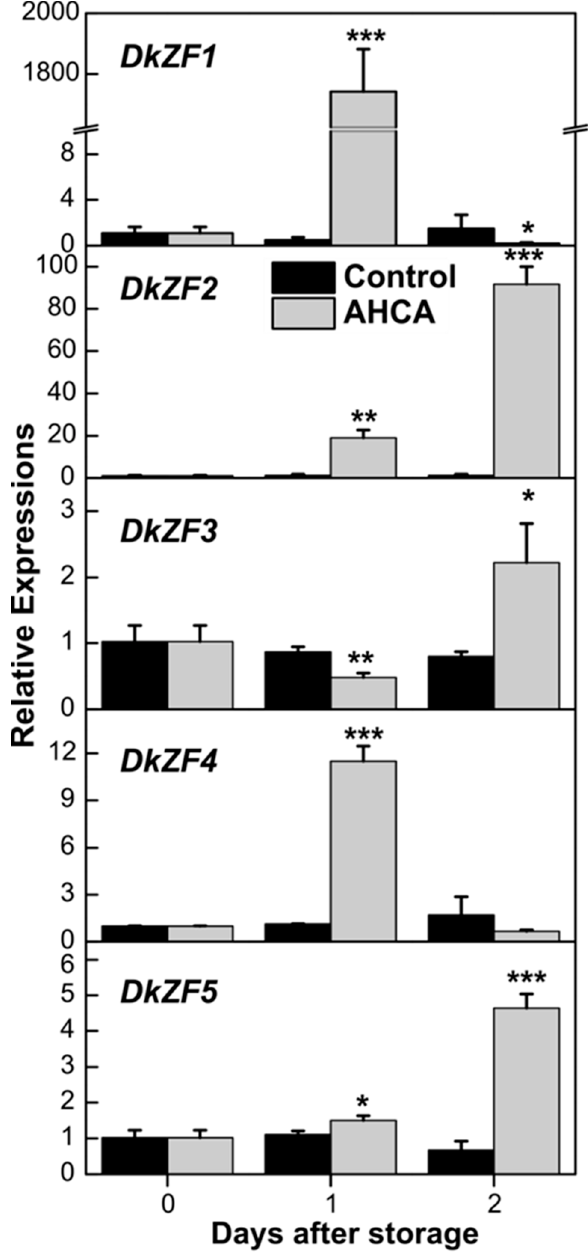
Figure 2. Expression analysis of DkZF genes in response to high-CO 2 atmosphere (AHCA) treatment in ‘Gongcheng-shuishi’ fruit. Transcripts of DkZF genes were measured by real time PCR and day 0 fruit values were set as 1. Error bars indicate standard errors from three biological replicates (* p < 0.05, ** p < 0.01, *** p < 0.001).